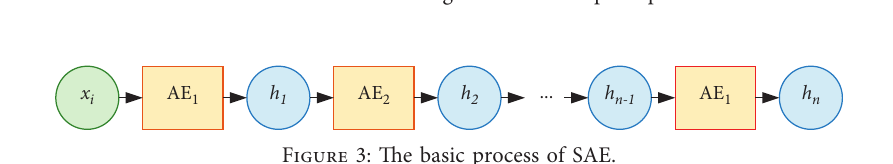
Figure 2: Schematic diagram of the AE principle.